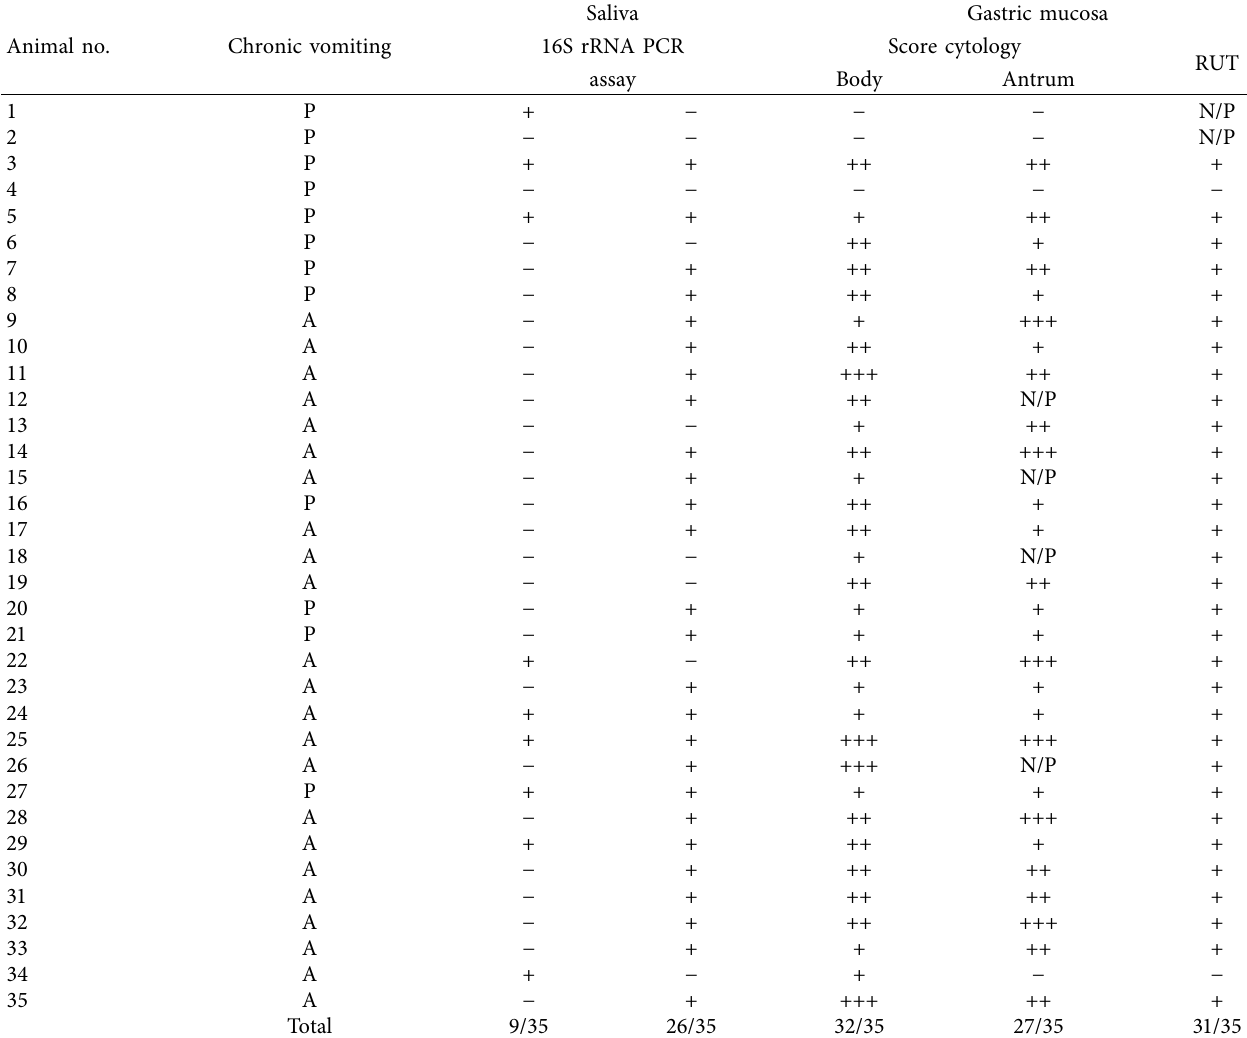
Table 1: Detection of Helicobacter spp., in different tests evaluated and gastric bacterial colonisation density scores. Animal no.